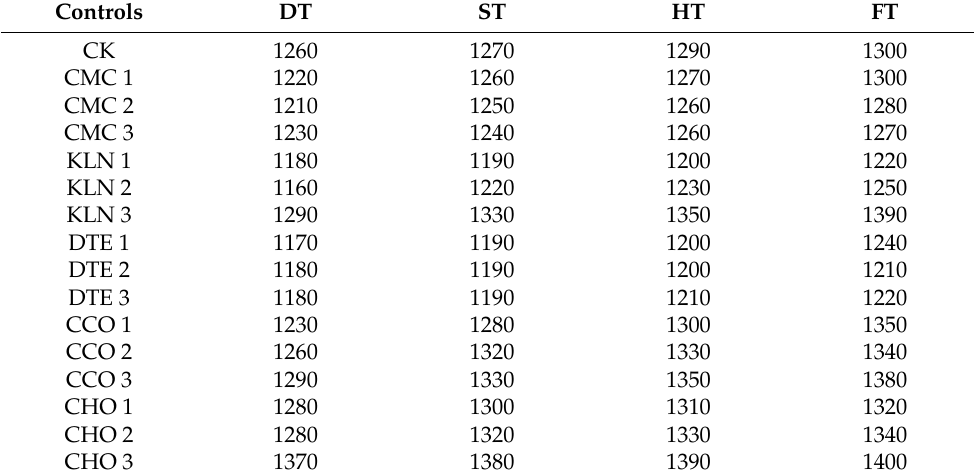
Table 3. Ash melting point of granular fuel with different additives ( ◦